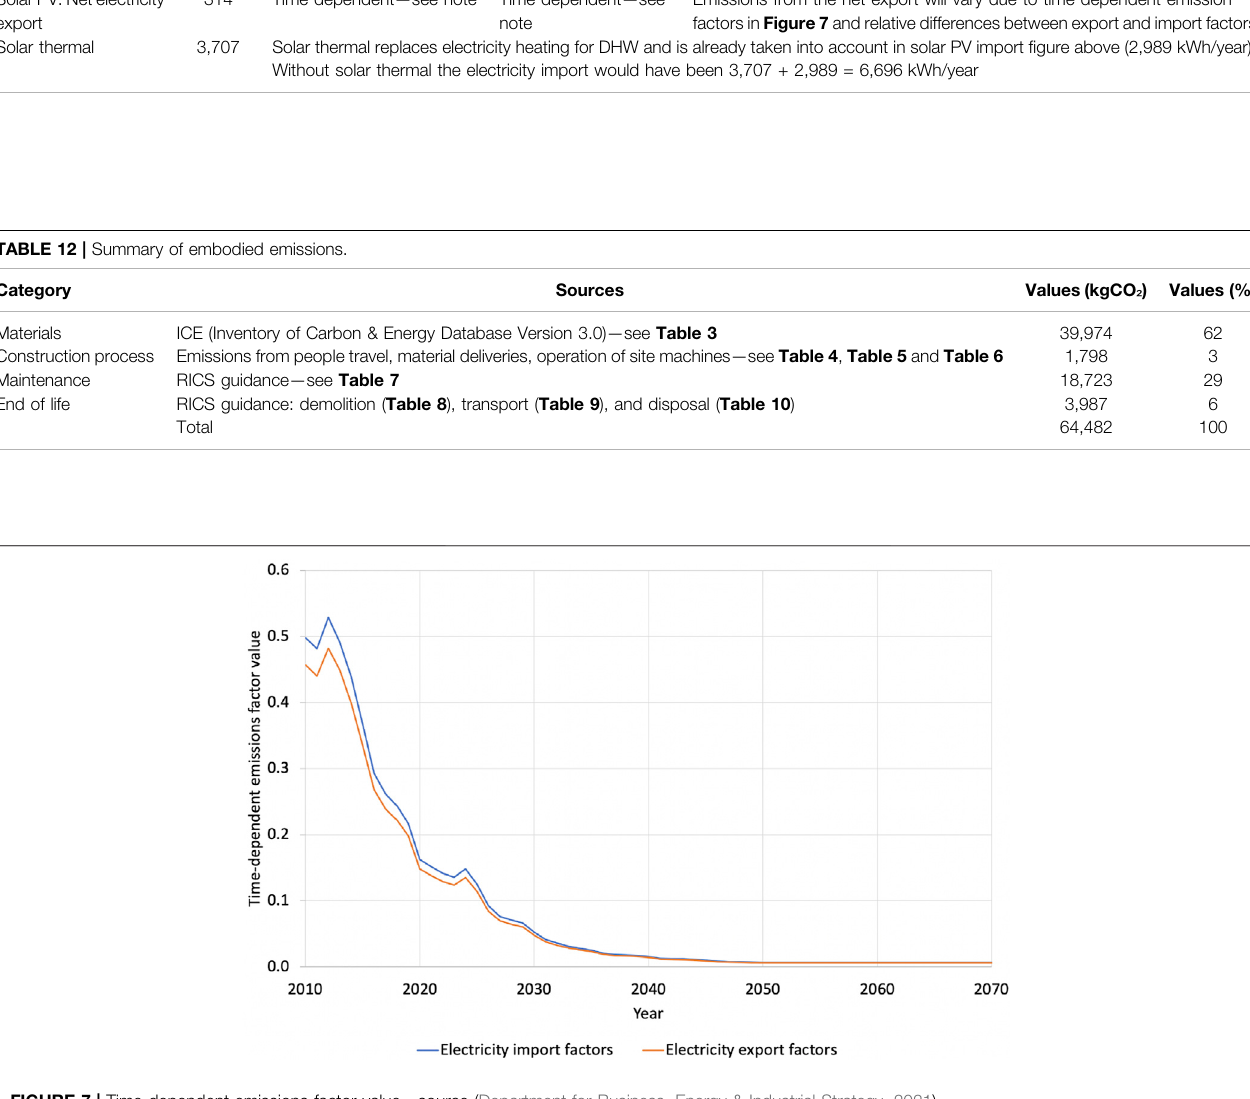
FIGURE 7 | Time-dependent emissions factor value — source (Department for Business, Energy & Industrial Strategy, 2021)